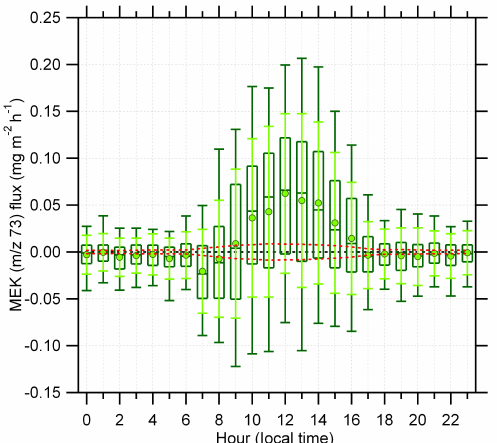
Figure 4. Hourly average MEK fluxes at the TT34 tower for the period September 2013–July 2014. The light-green circles repre- sent means and associated error bars are 1 standard deviation. The central line of the box plots (dark green) indicates the median, the bottom and top lines are the 25th and 75th percentile, respectively, and whiskers are the 5th and 95th percentiles. Red dashed lines in- dicate the propagated limit of detection calculated according to the method outlined by Langford et al.